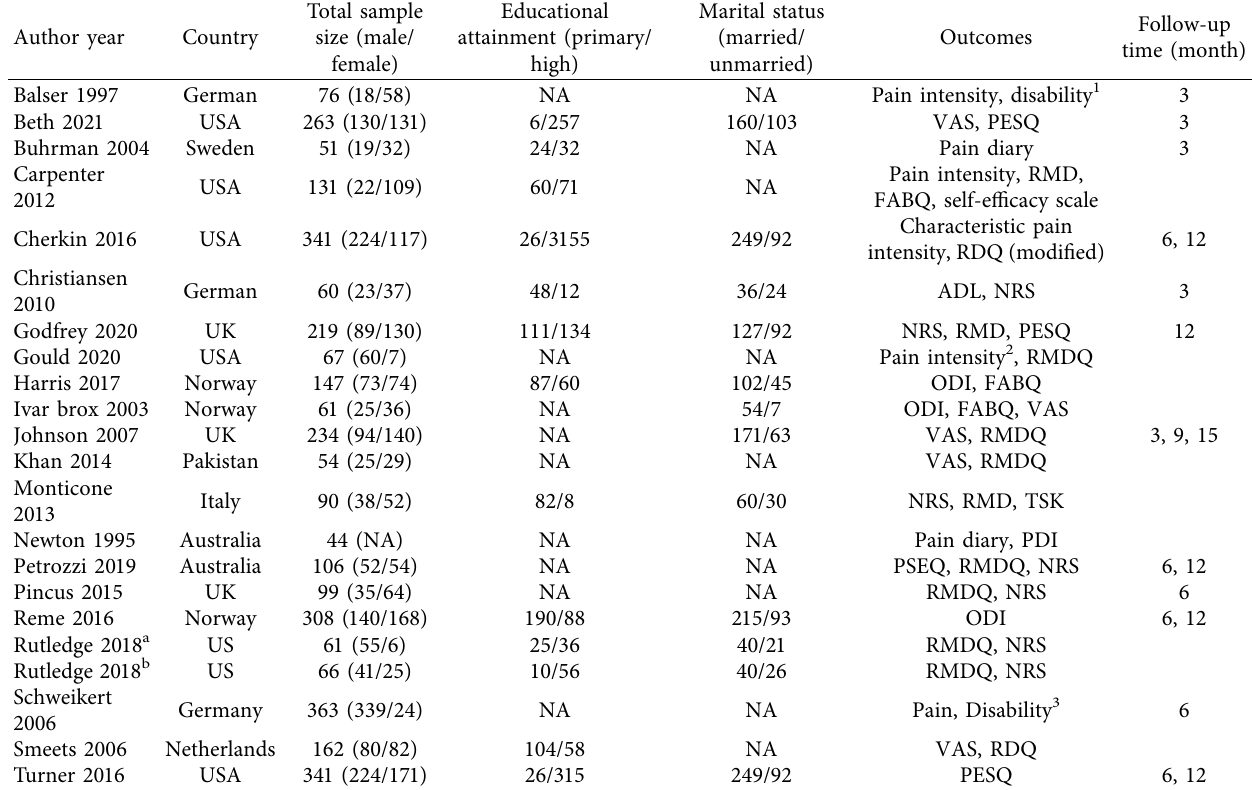
Table 1: Basic characteristics of the included studies.